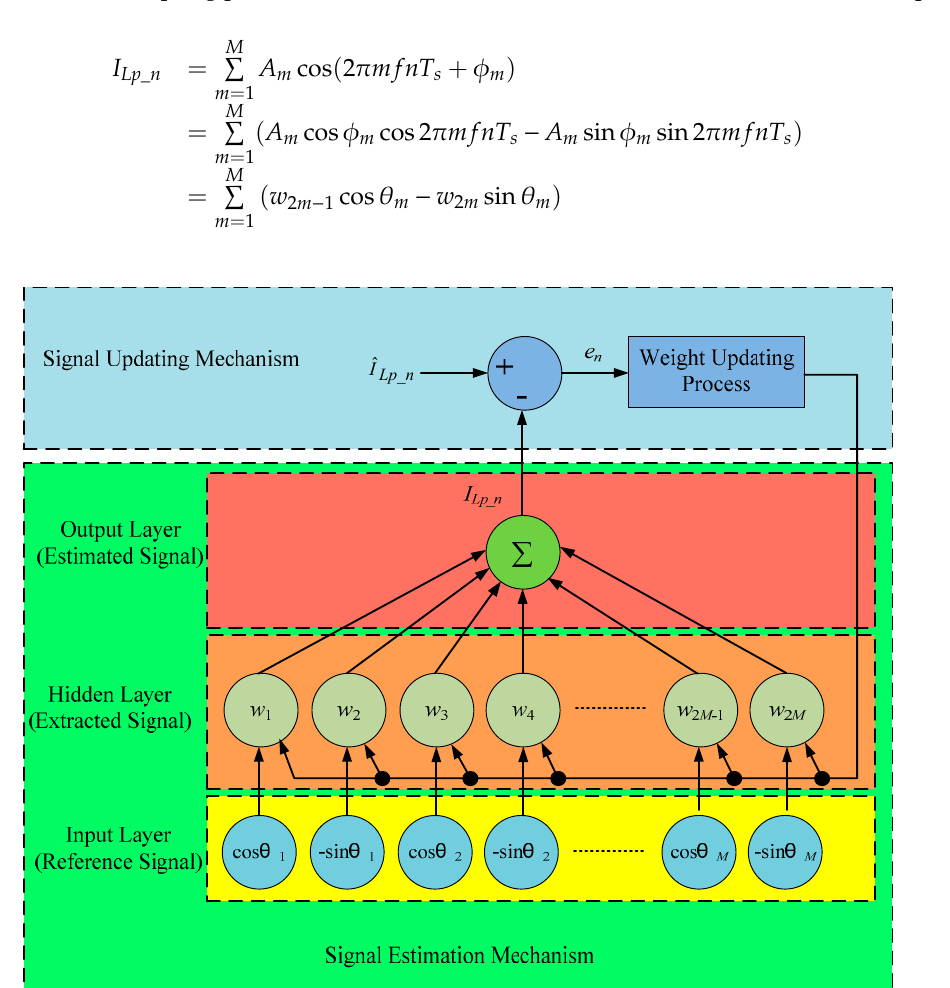
Figure 3. Architecture of the adaptive linear neural network (ALNN).